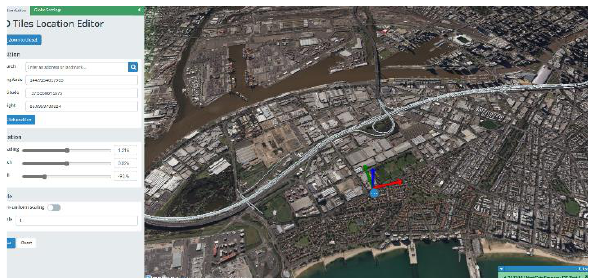
Figure 5: Complex model for multilevel freeway shown in Cesium Ion™ platform, modelled in and imported from Autodesk 3Ds Max using glTF format. Image credit Anna Müeller